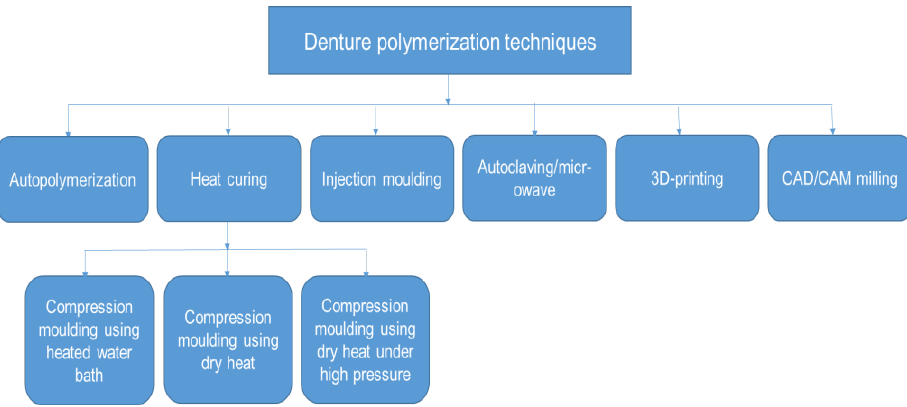
Figure 1. Schematic diagram of the contemporary denture polymerization techniques.